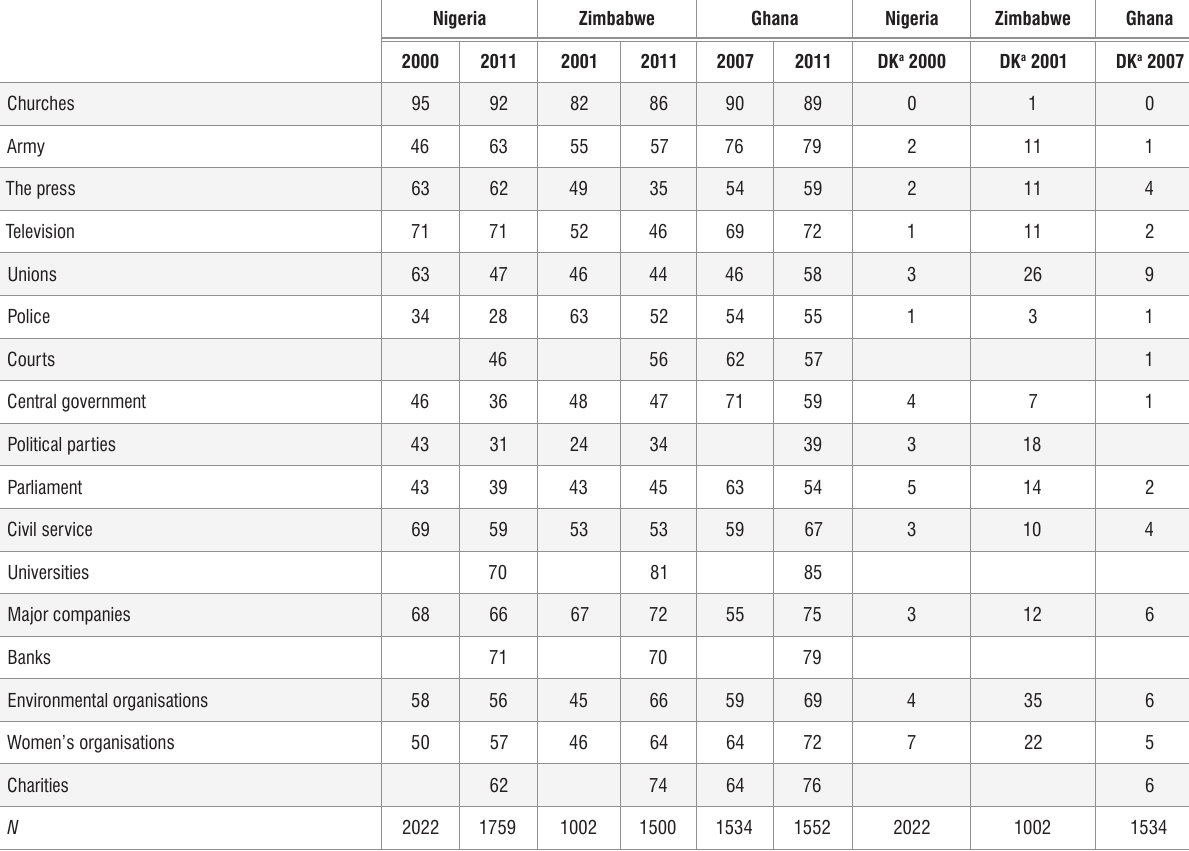
Table 2: Changing levels of confidence in African countries (%) Nigeria Zimbabwe Ghana